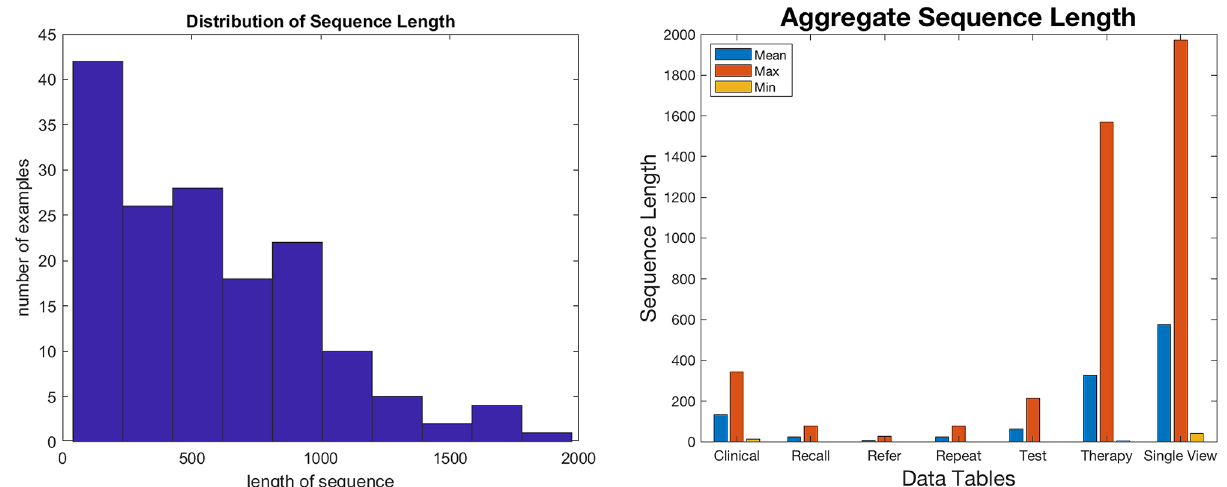
Figure 1. Plots showing the uneven sequence length distribution and the aggregate mean, maximum and minimum length distribution according to the